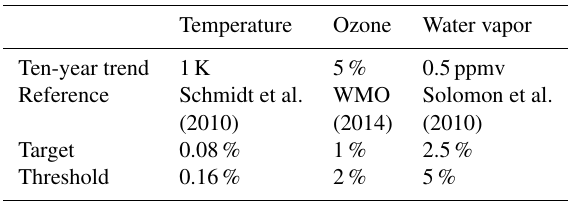
Table 1. Long-term trends in temperature, ozone, and water vapor in the UTLS region and the derived target and threshold values for GLORIA